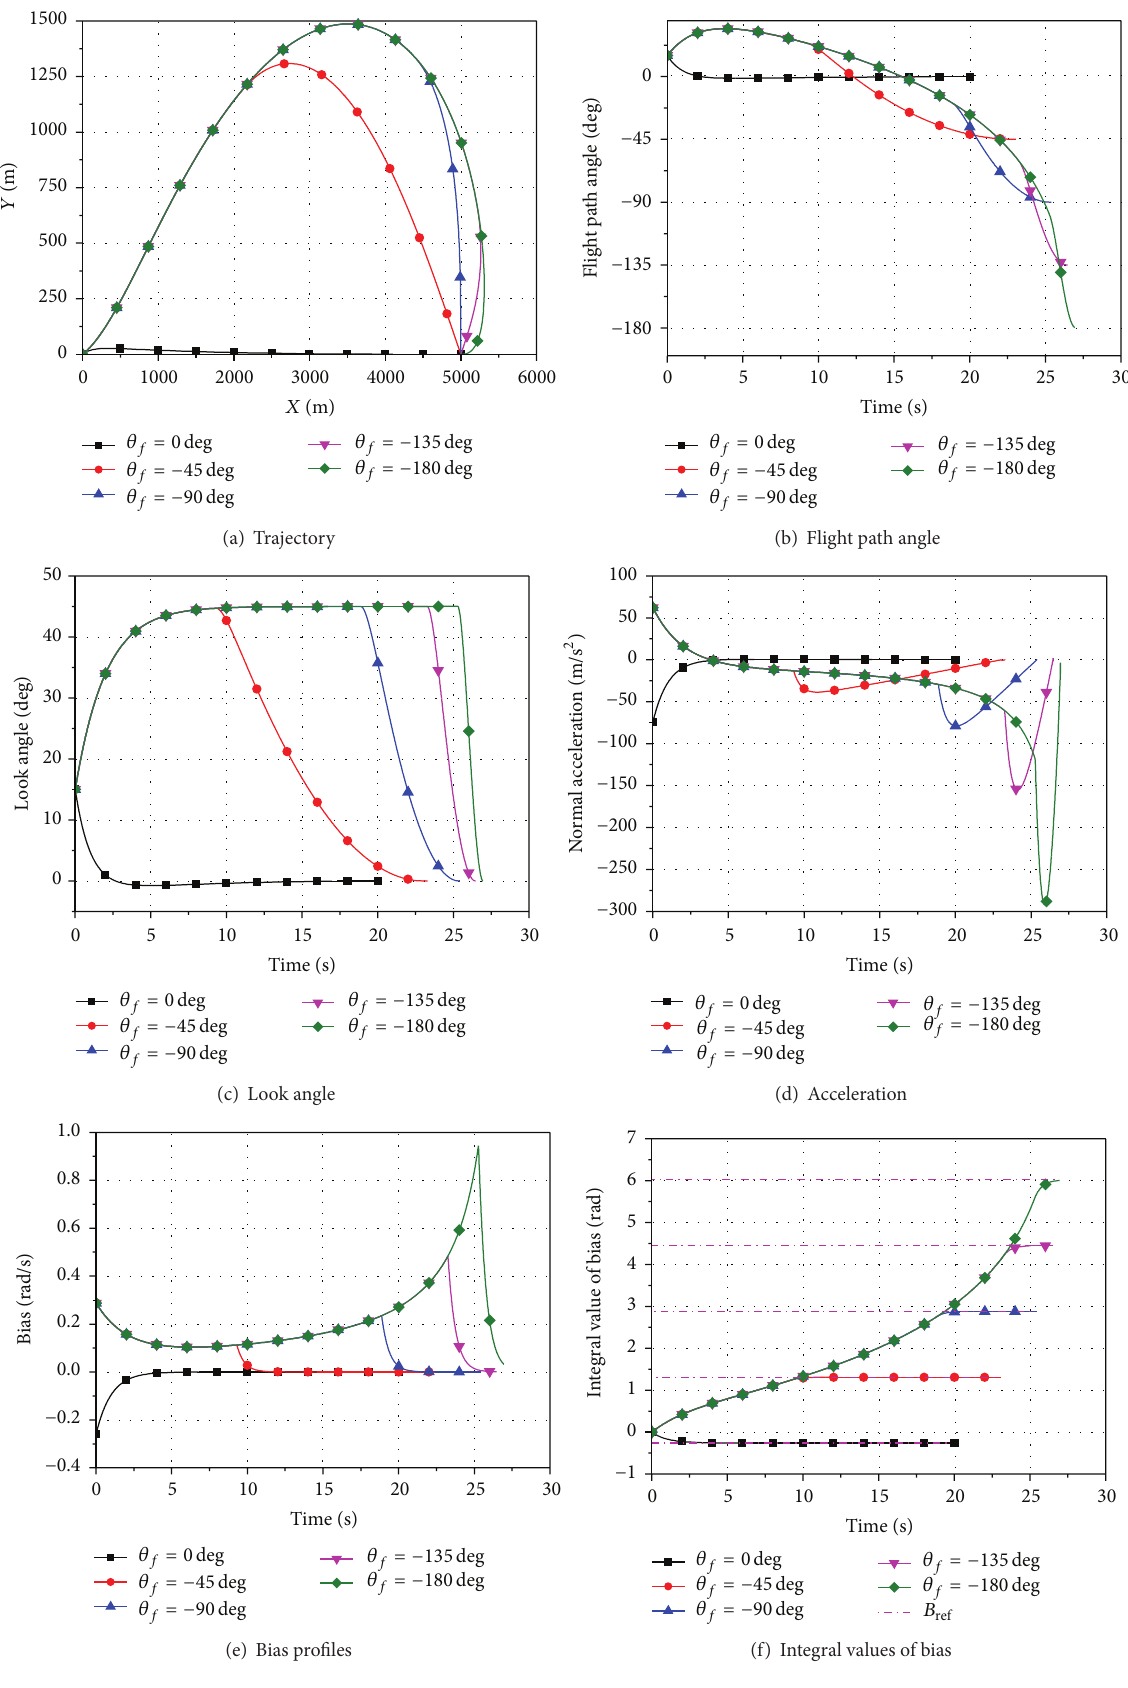
Figure 3: Simulation results for constant speed missile